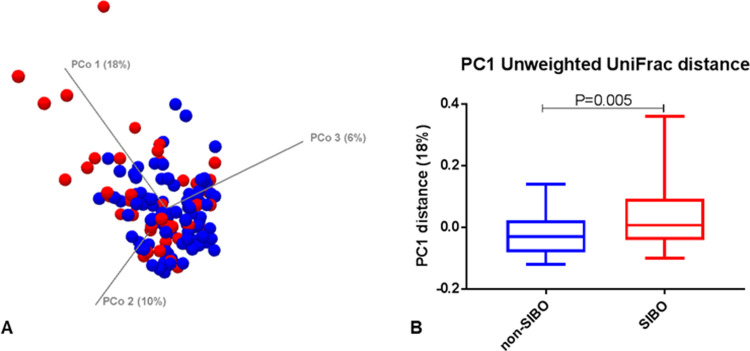
A- Principal Coordinates Analysis (PCoA) of both binary and abundance Unweighted UniFrac distances between SIBO (red) and non-SIBO (blue) subjects. B–PC1 distance plot.